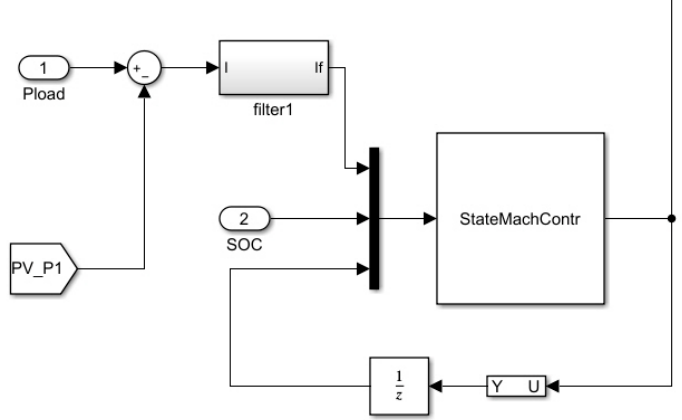
Figure 22. Frequency decoupling and state machine configuration.